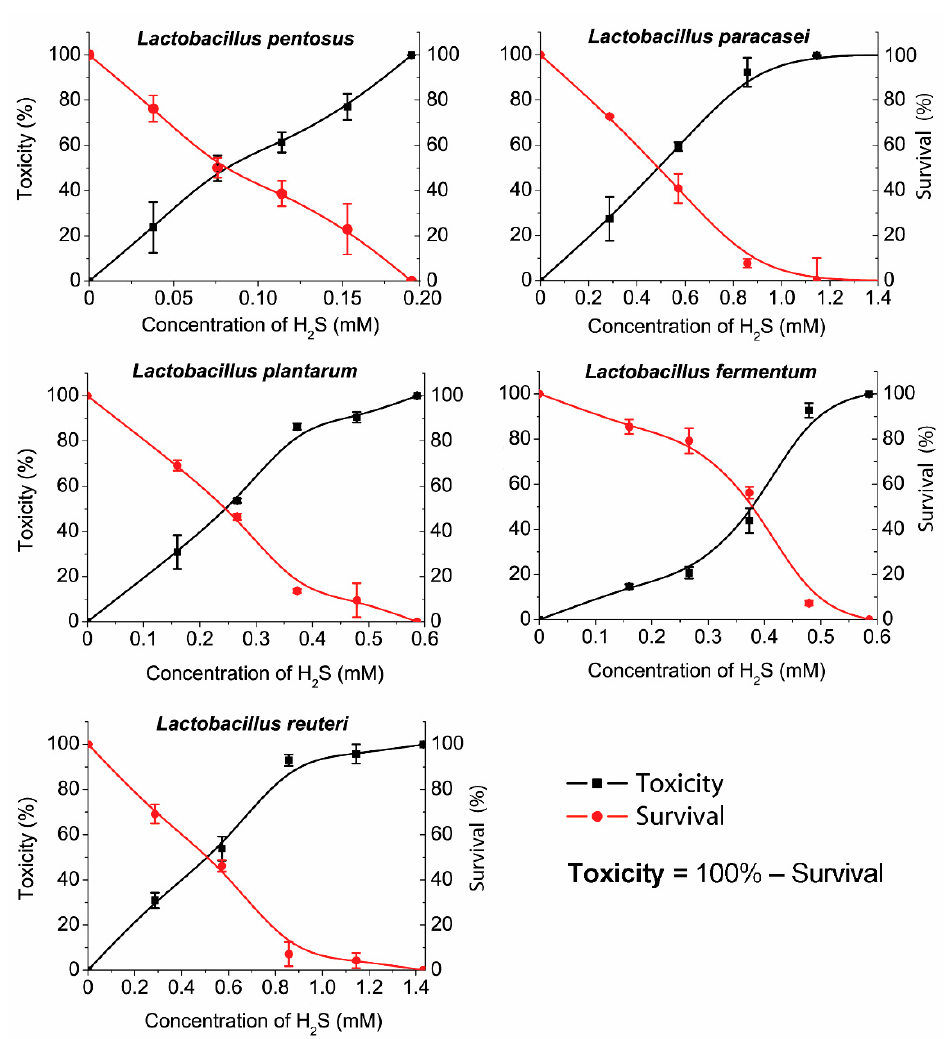
Figure 4. The survival of Lactobacillus species and the toxicity of hydrogen sulfide.